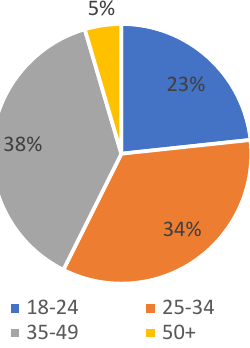
Figure 1. Age distribution pilot participants.